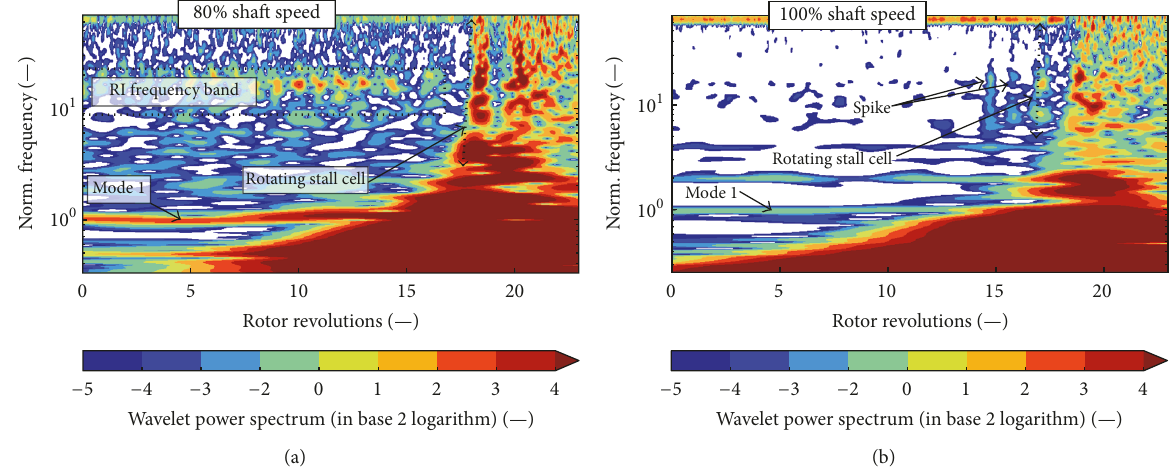
Figure 4: Wavelet power spectra for the green signals (2nd circ. pos. from the bottom) in Figure 3 for 80% (a) and 100% (b).